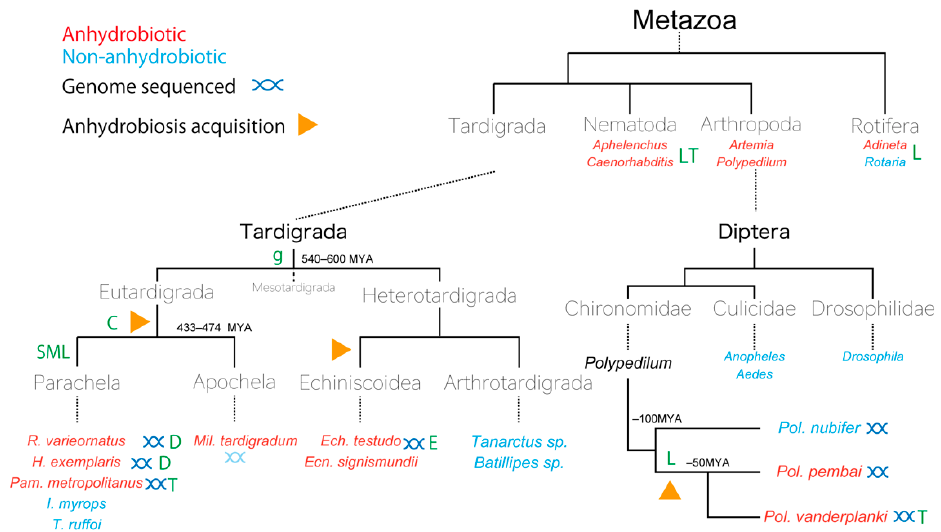
Figure 1. Distribution of anhydrobiosis and associated molecular mechanisms in invertebrates. Illustration of the phylogeny of anhydrobiotic species and major molecular mechanisms associated with them. The predicted emergence point of lineage-specific molecular species is indicated at the last common ancestor (i.e., CAHS proteins emerged somewhere before the divergence of Apochela and Parachela). Only lineages that contain anhydrobiotic species are indicated. Brown arrows indicate possible acquirement points of anhydrobiosis machinery. Green letter annotations indicate the conservation/utility of corresponding proteins/compounds: C: CAHS; S: SAHS; M: MAHS; L: LEA (includes LEAM); D: Dsup; g: Rv.g12777; T: Trehalose. Red and blue taxonomic labels indicate